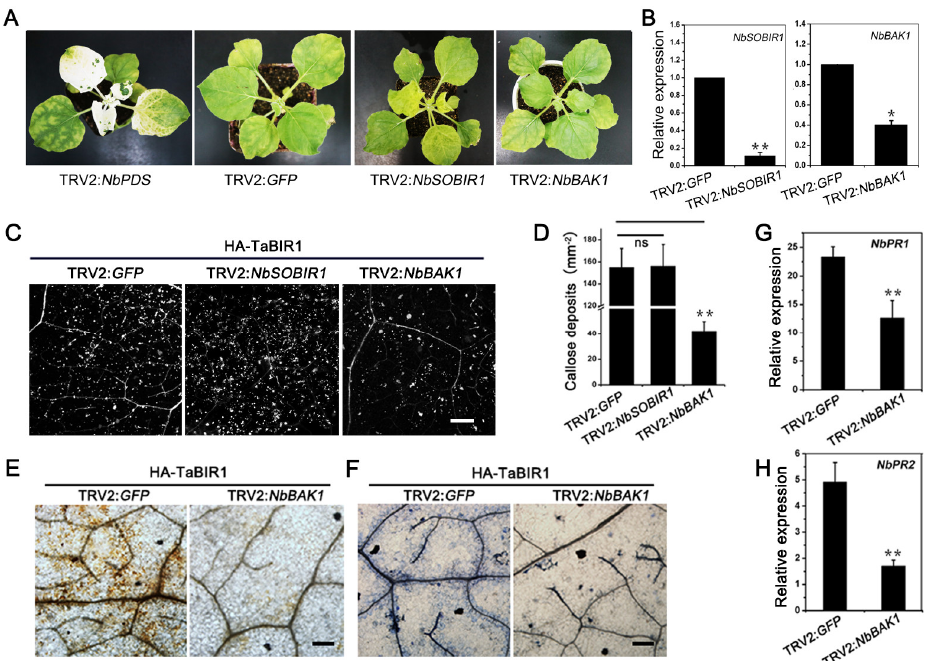
Figure 6. NbBAK1 is required for TaBIR1 triggered immunity. ( A ) Transient silencing of NbSOBIR1 and NbBAK1 in N. benthamiana mediated by tobacco rattle virus (TRV). Photobleaching was observed on plant leaves inoculated with TRV2: PDS two weeks later. GFP, negative control. ( B ) Silencing efficiency of NbSOBIR1 and NbBAK1 analyzed by qRT-PCR. Values represent the means ± standard errors using Student’s t -tests. (* p < 0.05, ** p < 0.01) ( C , D ) Transient silencing of NbBAK1 reduced callose reposition triggered by TaBIR1 in N. benthamiana . Plant leaves were inoculated with TRV2: NbBAK1 , TRV2: NbSOBIR1 and TRV2: GFP , on which two weeks later HA tagged TaBIR1 was transiently expressed via agrobacterium mediated infiltration. Forty-eight hours post infiltration, the leaves were stained by aniline blue for callose deposition observation. The number of callose deposits per mm 2 was quantified. TRV2: GFP was used as the negative controls. Bars, 300 µm. ns, no significance, ** p < 0.01. Data are means ± standard errors from three biological replications. ( E ) Observation of DAB stained H 2 O 2 and ( F ) trypan blue stained cell death in GFP and NbBAK1 silenced leaves expressing HA-TaBIR1. Bars, 100 µm. ( G , H ) qRT-PCR analysis of NbPR1 and NbPR2 expression. Values represent the means ± standard errors. ** p < 0.01, significant differences from three biological replicates using two-tails unpaired Student’s t -tests.